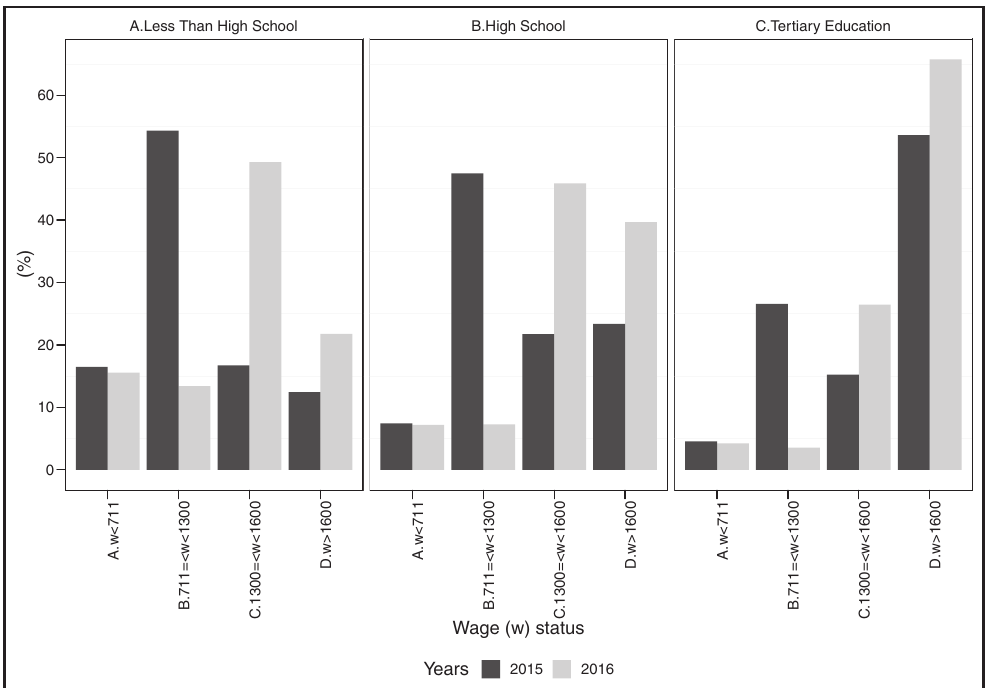
Wage groups potentially affected by the minimum wage increase in 2016, by